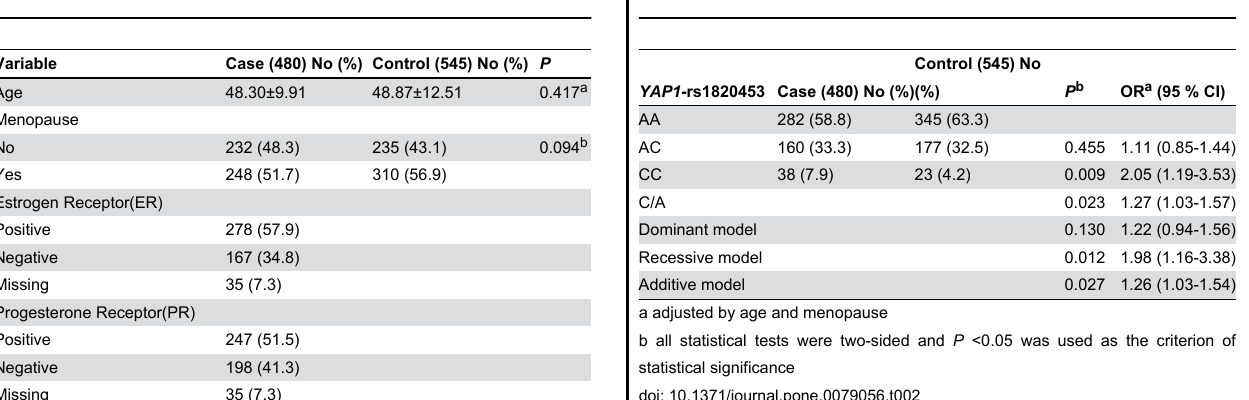
Table 1. The characteristics of the case-control study population.